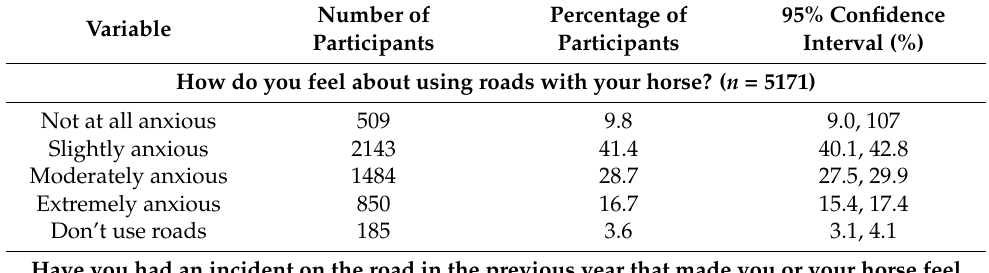
Table 4. A summary of UK equestrians’ ( n = 5171) horse-related road incident